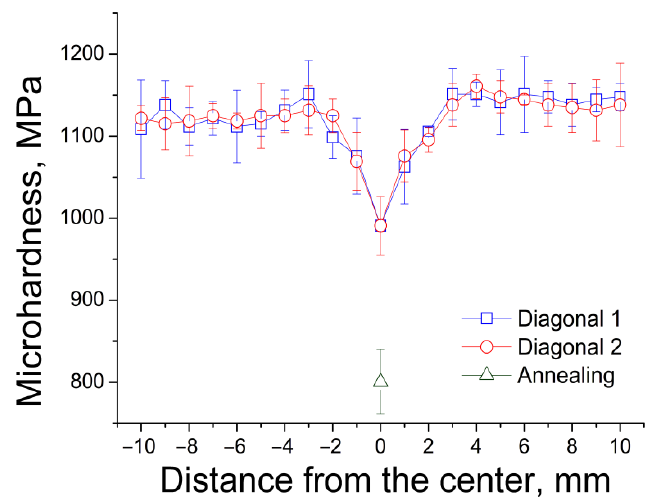
Figure 4. Distribution of microhardness of the alloy over the diameter of the sample after HPT.